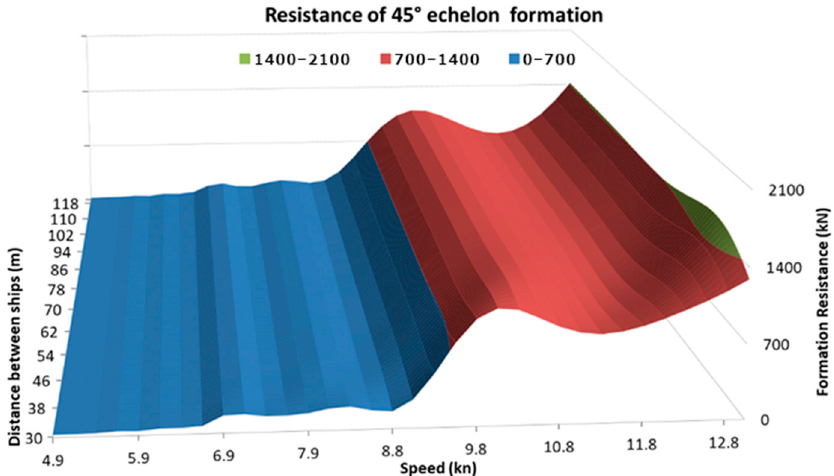
Figure 10. Total resistance of a formation consisting of four tugboats sailing in an echelon formation with an angle of 45°.